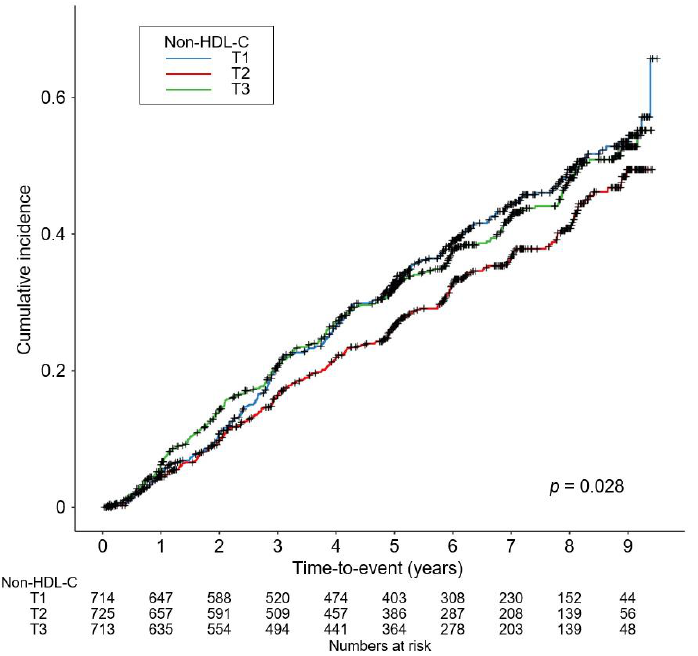
Figure 2. Kaplan–Meier survival curve for cumulative incidence of composite renal event by nHDL. p value by Log-rank test. Abbreviations: nHDL, non-high-density lipoprotein cholesterol; T1, 1st tertile; T2, 2nd tertile; T3, 3rd tertile.